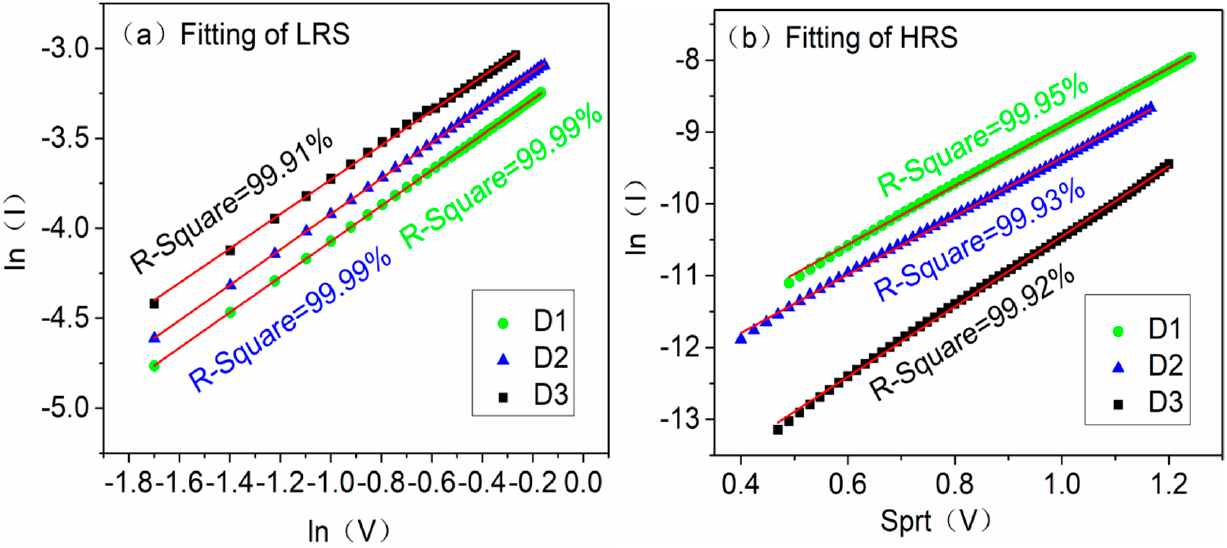
Figure 8. For the D1, D2, and D3 devices: ( a ) linear fit of LRS, ( b ) linear fit of HRS. (R-squared values are all greater than 99.9%, and are marked in the figure).